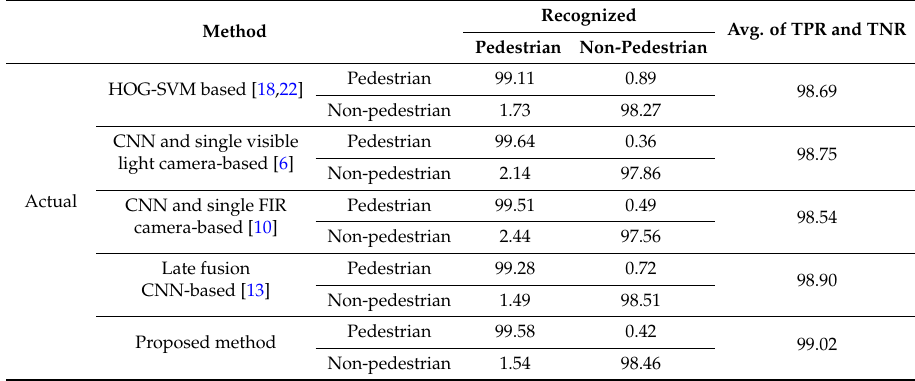
Table 12. Comparisons of classification accuracies with OSU color-thermal database based on the confusion matrix (unit: %).